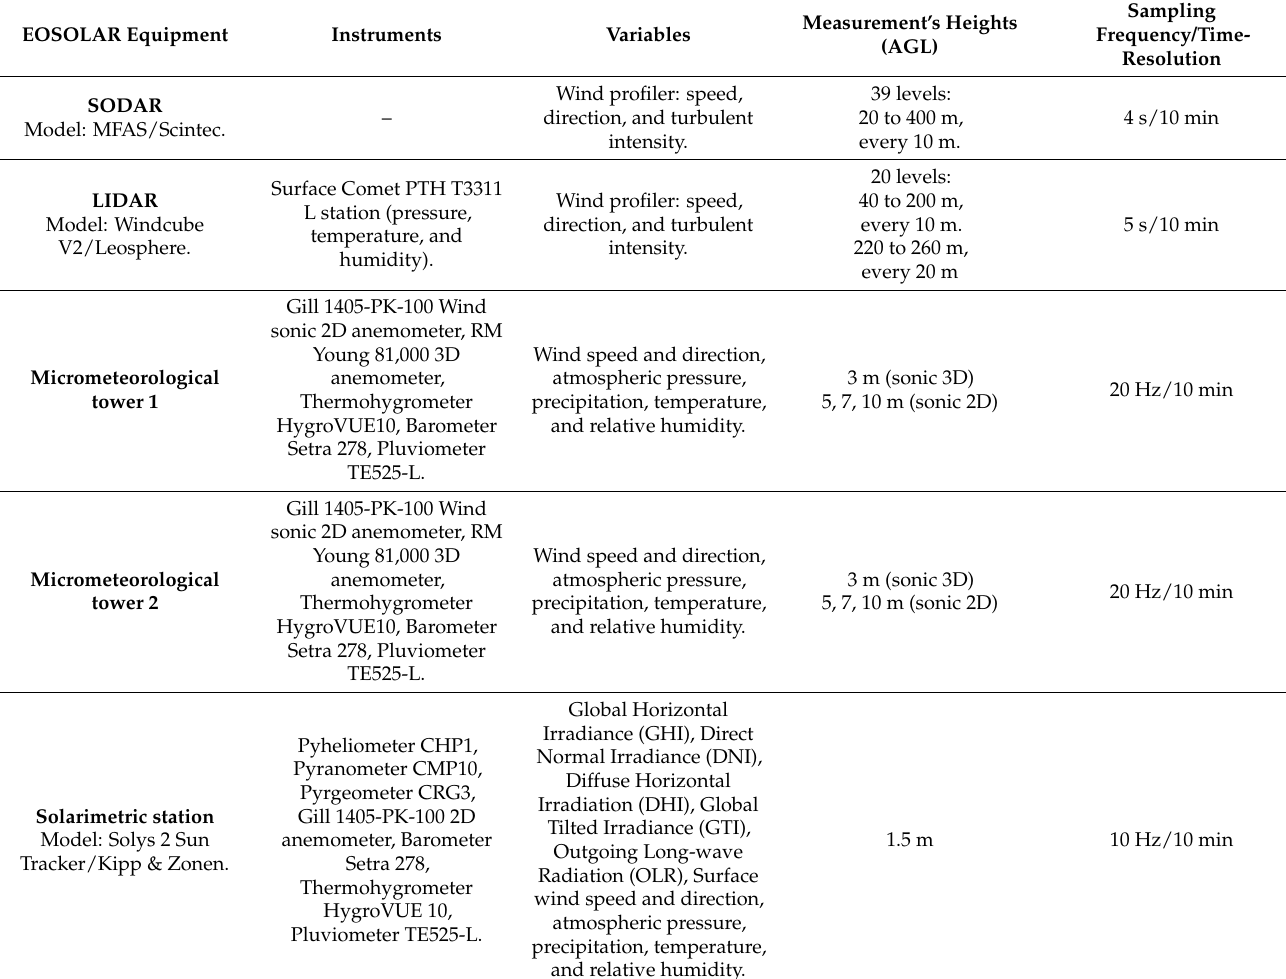
Table 1. Equipment, auxiliary instruments, variables, measuring heights and sampling frequency. AGL refers to above the ground